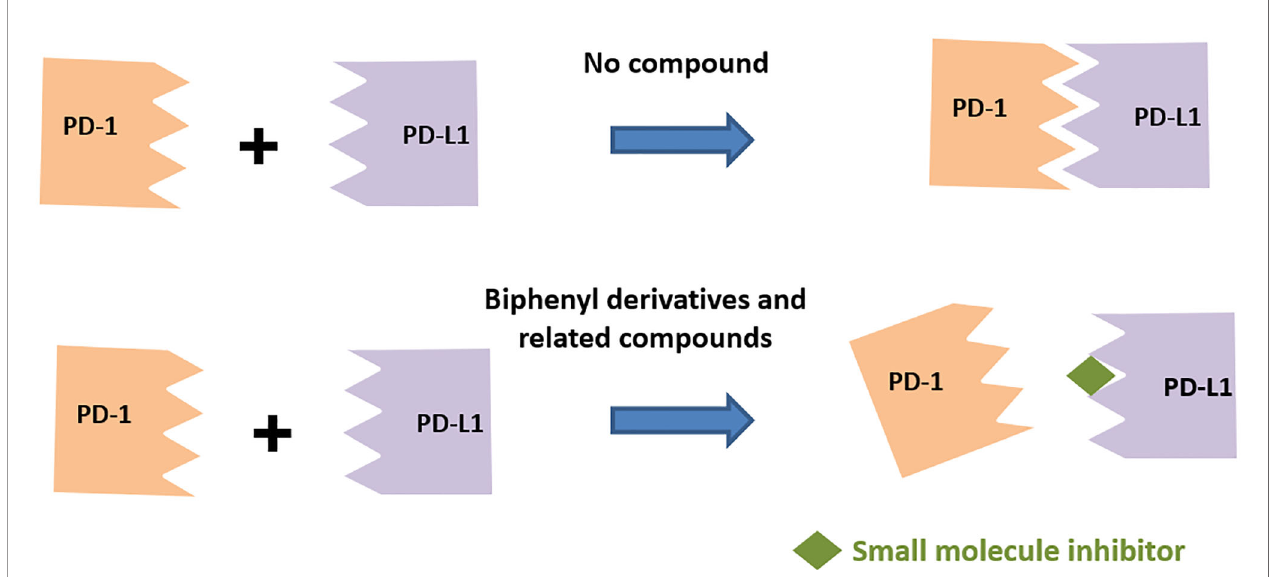
FIGURE 1 | Compounds based on the biphenyl scaffold, originally identi fi ed by a conventional approach of screening compounds in an assay for prevention of the PD-1, PD-L1